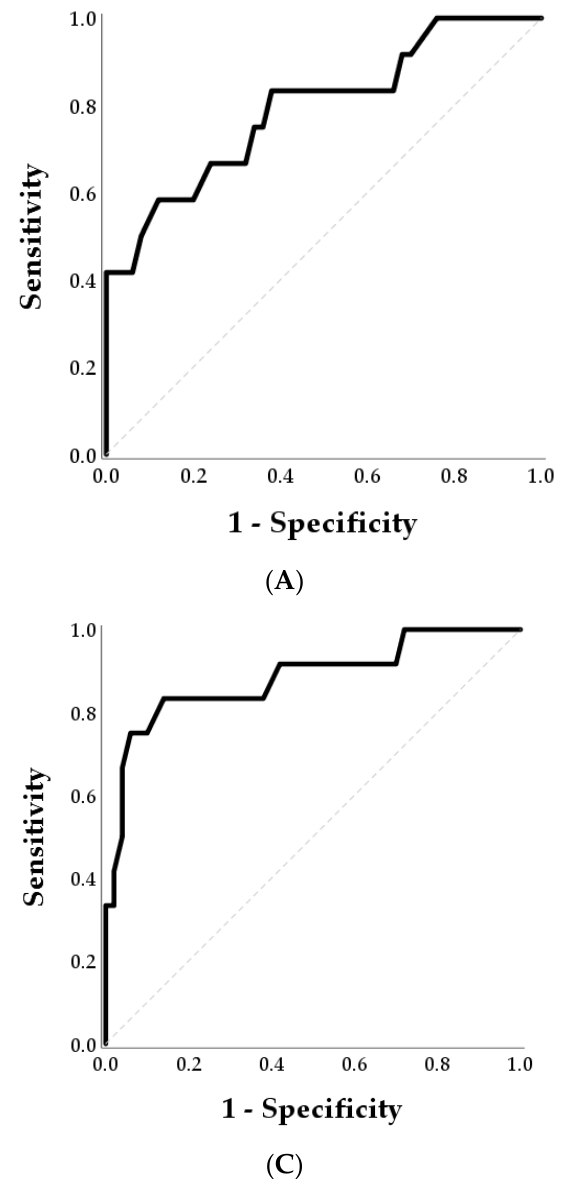
7 of 16 Table 2. Results of Receiver Operator Characteristic (ROC) analysis including the area under the ROC curve (AUC) with corresponding 95% confidence intervals (CI) and p -values, optimal cut-off with associated sensitivity, specificity and ac- curacy values. Day